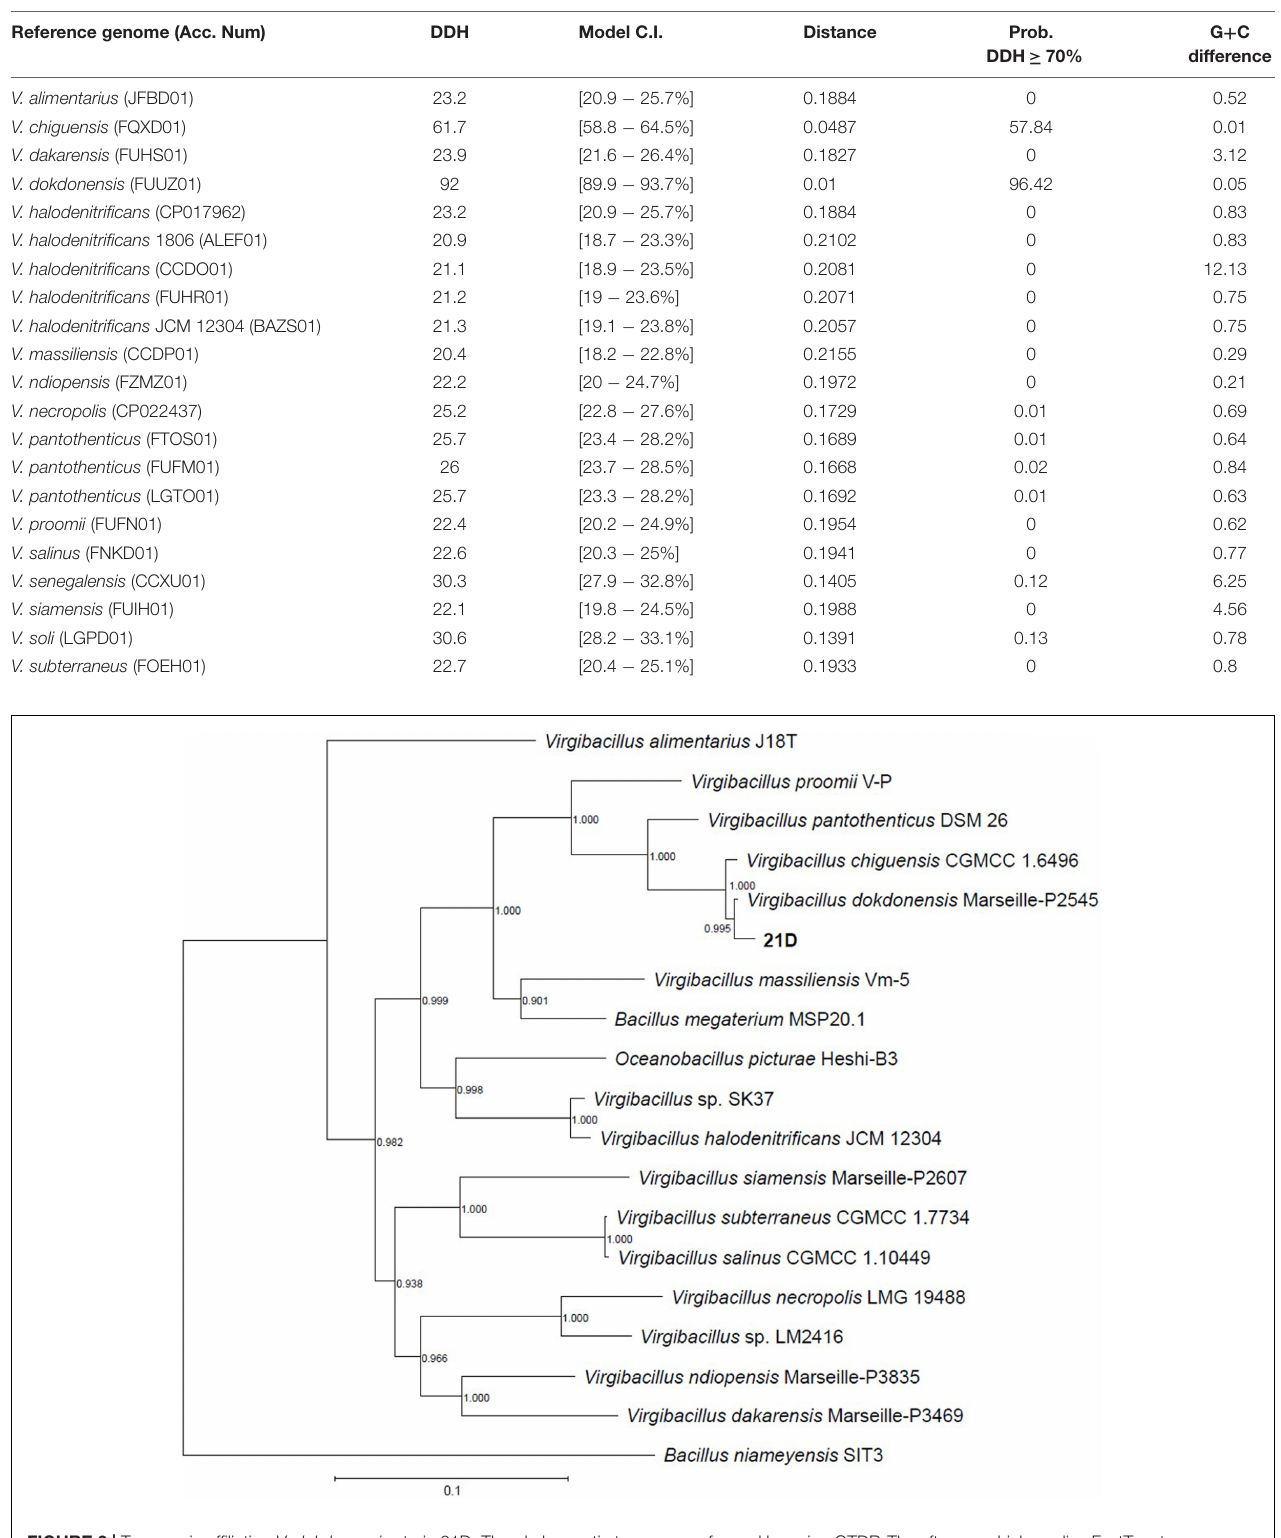
FIGURE 3 | Taxonomic affiliation V. dokdonensis strain 21D. The phylogenetic tree was performed by using GTDB-Tk software, which applies FastTree to a concatenated alignment of 120 ubiquitous single-copy genes. Numbers at the nodes are bootstrap values obtained by repeating the analysis 100 times.